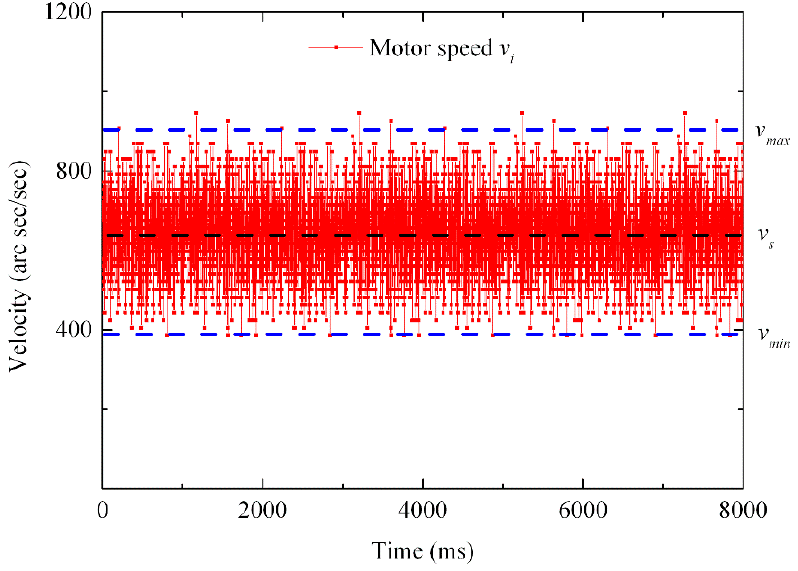
Figure 29. Motor speed measurement diagram.